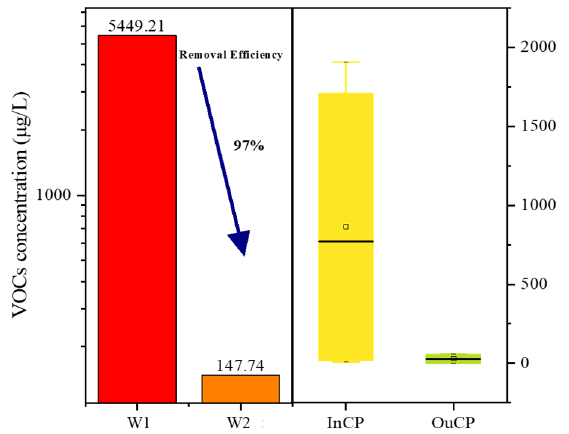
Figure 2. VOCs concentrations in the water samples collected at the sewage treatment plant (W1, W2), inside the park (InCP), and outside the park (OuCP).